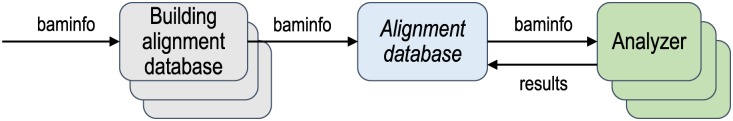
Analyzer plug-ins.Analyzer plug-in codes obtain field values of alignments from database and save analysis results in database. Each analyzer plug-in code can use multiple threads. In this example, three threads execute analyzer plug-in.